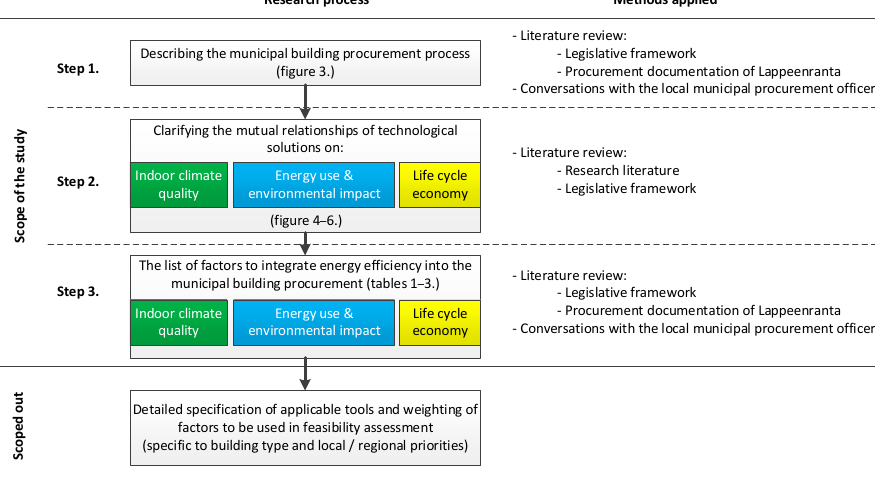
Figure 2. The research process and applied methods.